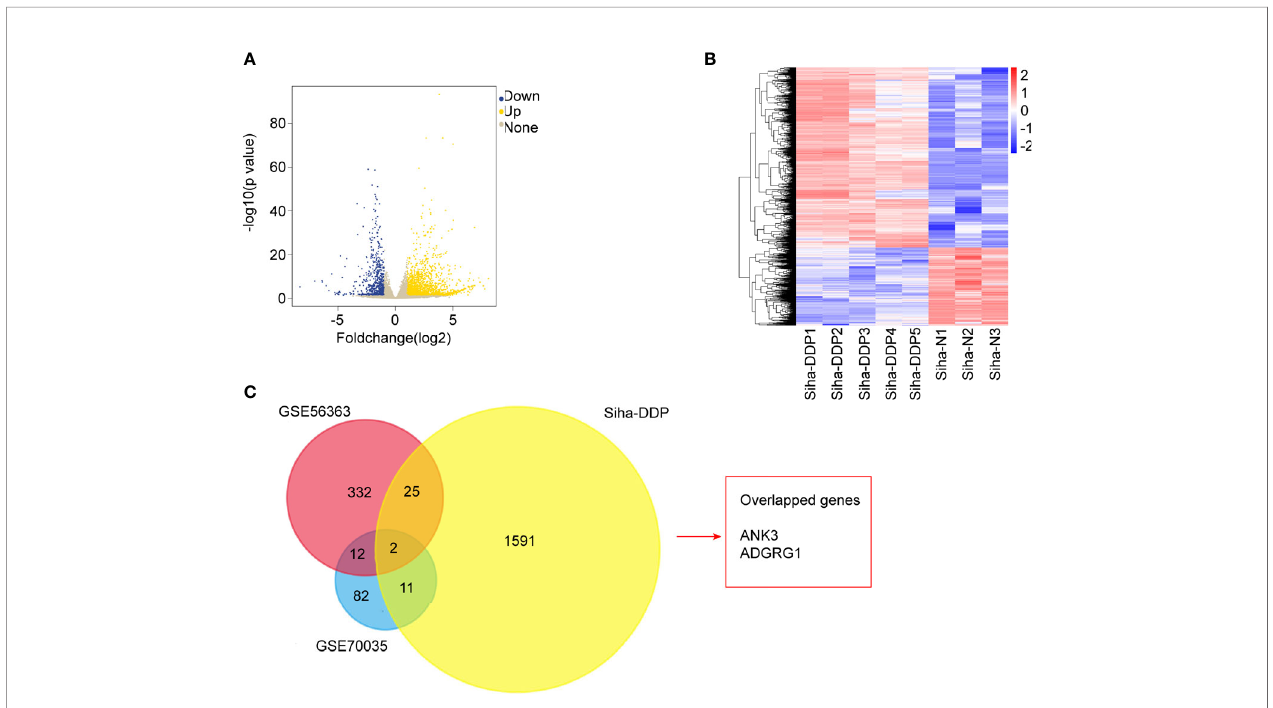
FIGURE 2 | RNA-sequencing and bioinformatics analysis of differentially expressed genes (DEGs). (A) Volcano plots of the 32,808 expressed genes. The X-axis represents “ log2 (Foldchange), ” and the y-axis represents “ -log10 (p-value). ” Yellow color represented upregulated genes, and blue color represented downregulated genes in cisplatin-resistant Siha cells (Siha-DDP) compared with the parental cells (Siha-N). (B) Clustering heatmap of the 2,337 differential expressed genes (DEGs). The criteria for DEGs are |Log2Foldchange|>1 and adjp-value<0.05. (C) Overlapped genes of three